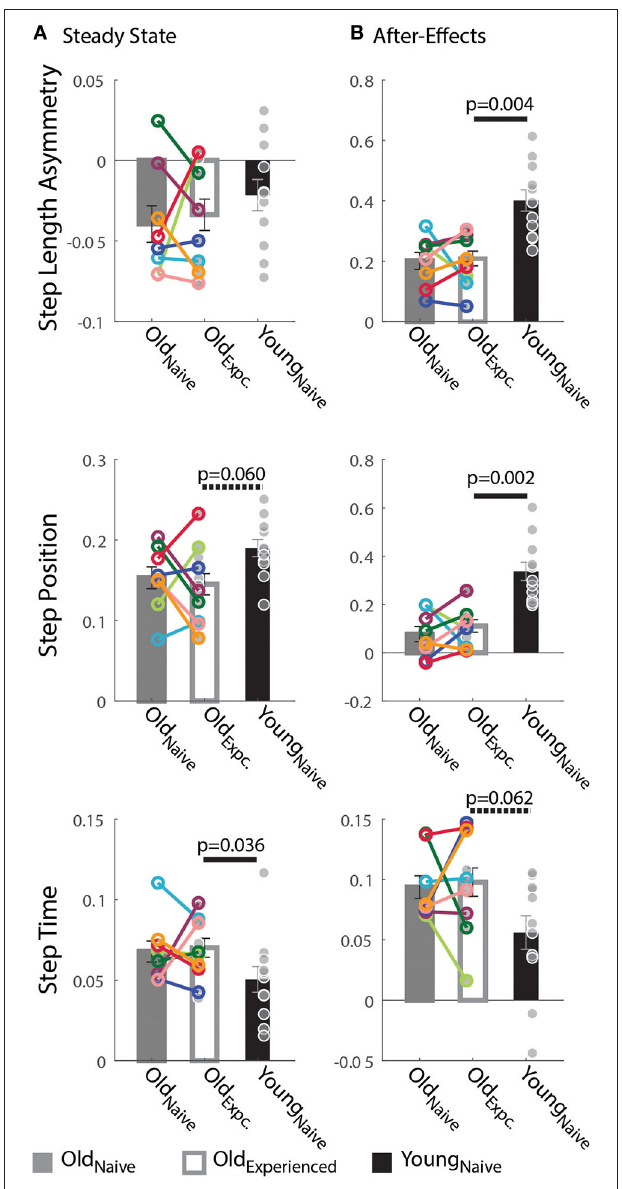
FIGURE 3 | Steady State and After-Effects on the Treadmill. (A,B) Bar plots indicate the group mean value ± standard errors. Individual subject behavior is indicated with dots. Dots edged and connected with colored lines ( n = 8) indicate paired data from the Old nave and Old experienced testing sessions that were used for statistical testing to determine the effect of exposure. Gray dots ( n = 11) indicate unpaired data from the Old experienced and Young nave groups that were used for statistical testing to determine if older adults could behave like naïve, younger adults with exposure. (A) Steady State: While all groups reached similar Step Length Asymmetry by the end of the Adaptation period, the spatial and temporal acquired patterns were different between older and younger subjects. Older adults adapted their StepTime more, whereas younger adults adapted their StepPosition more. (B) After-Effects: Large After-Effect values indicate greater change in the gait pattern acquired on the split-belt treadmill. Consistent with the Adaptation phase, older adults had greater StepTime adaptation effects, whereas younger participants exhibited more StepPosition